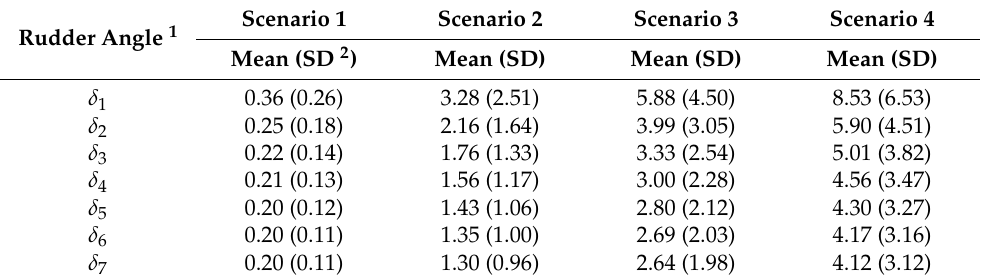
Table 3. Average critical latency value in minutes for each rudder angle. Rudder Angle 1